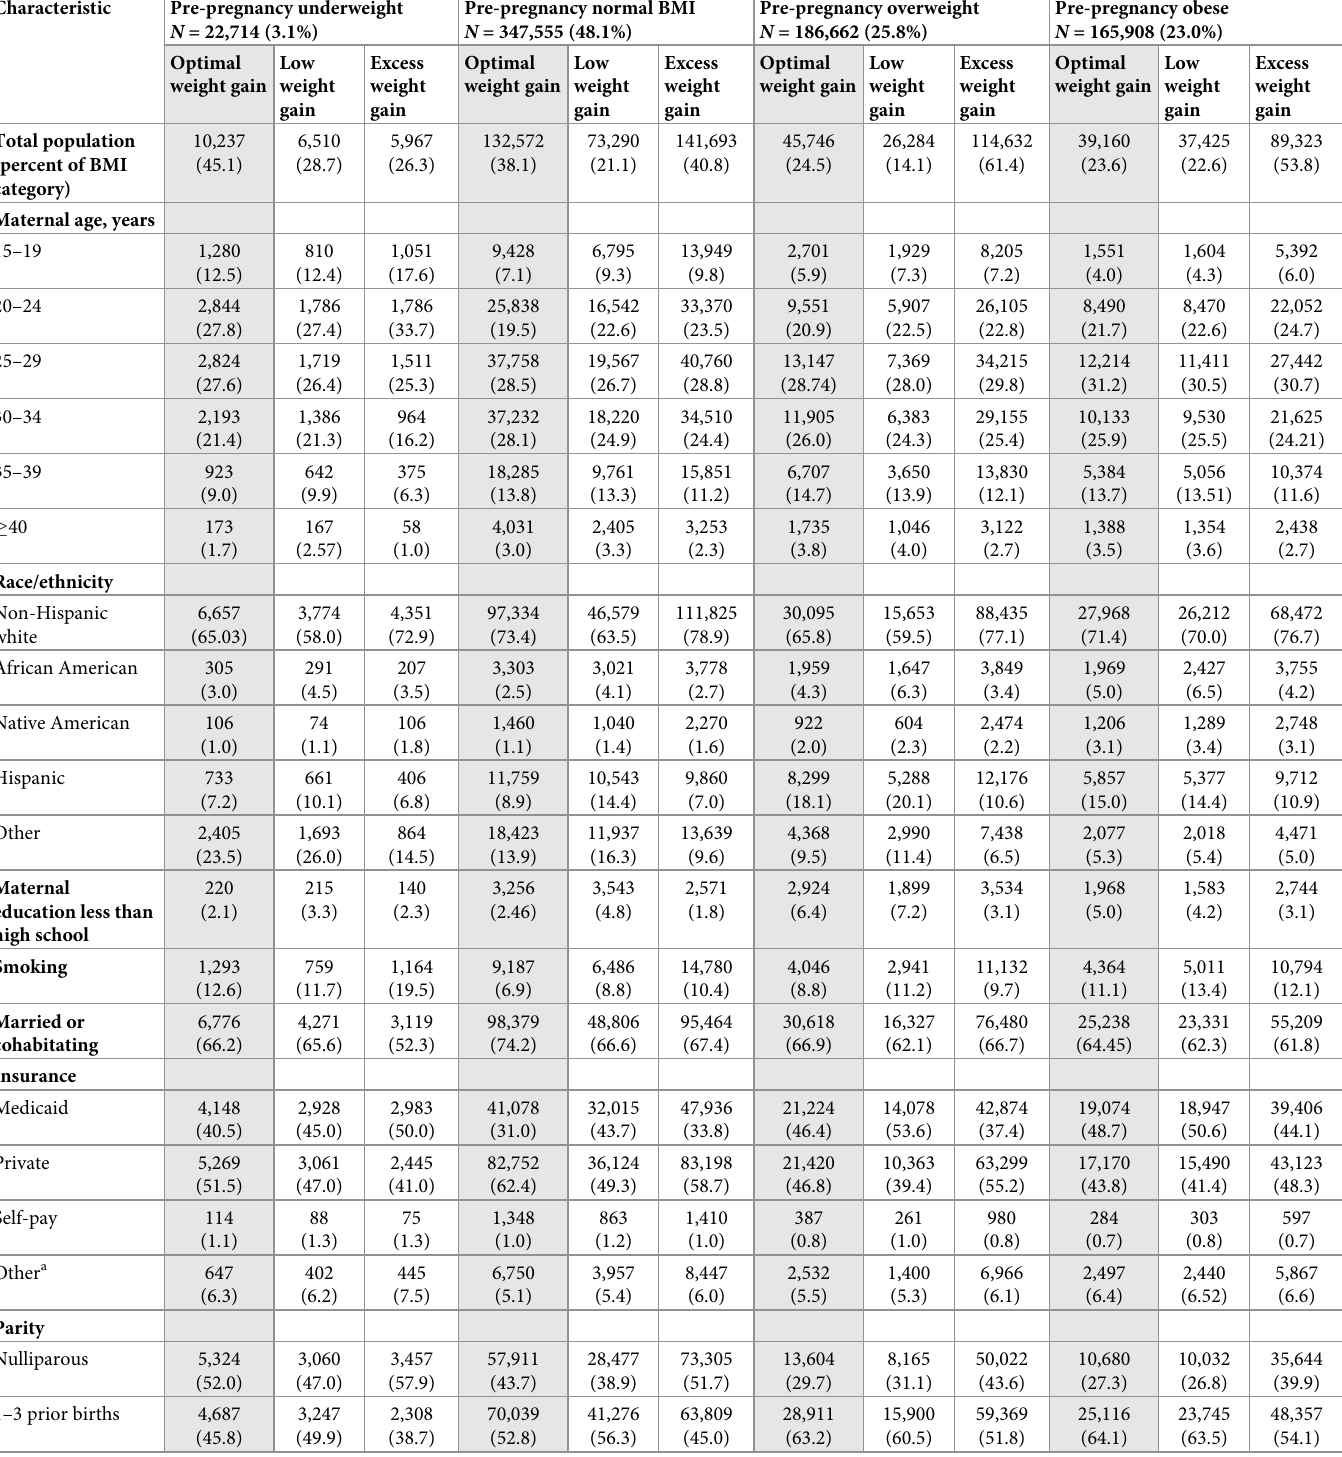
Table 1. Demographic and pregnancy characteristics by pre-pregnancy BMI and gestational weight gain—Singleton births, Washington State, 2004–2013.